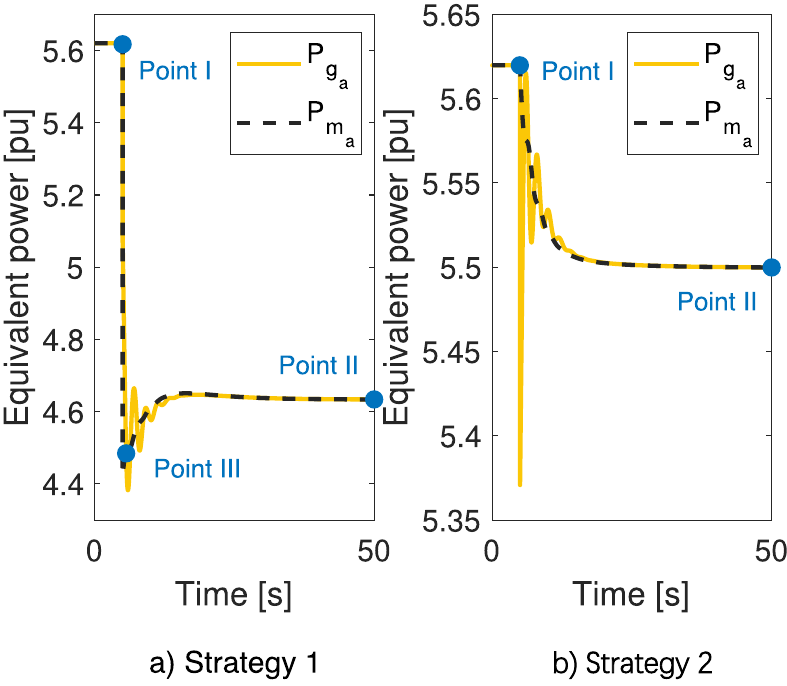
Figure 5. Strategies for the polynomial fitting